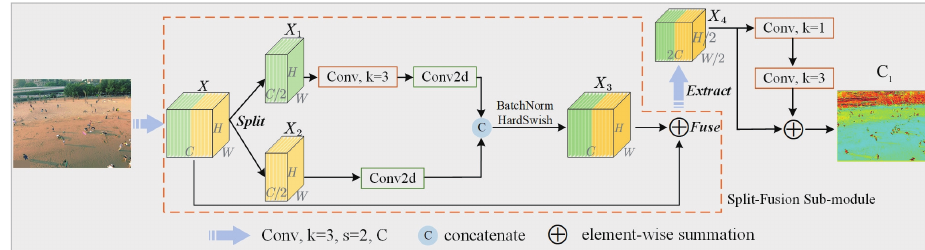
Figure 3. The structure of ASPConv. The multi-scale local context information of small objects is first adaptively learned in a split-fusion sub-module, and then fused to form detailed spatial